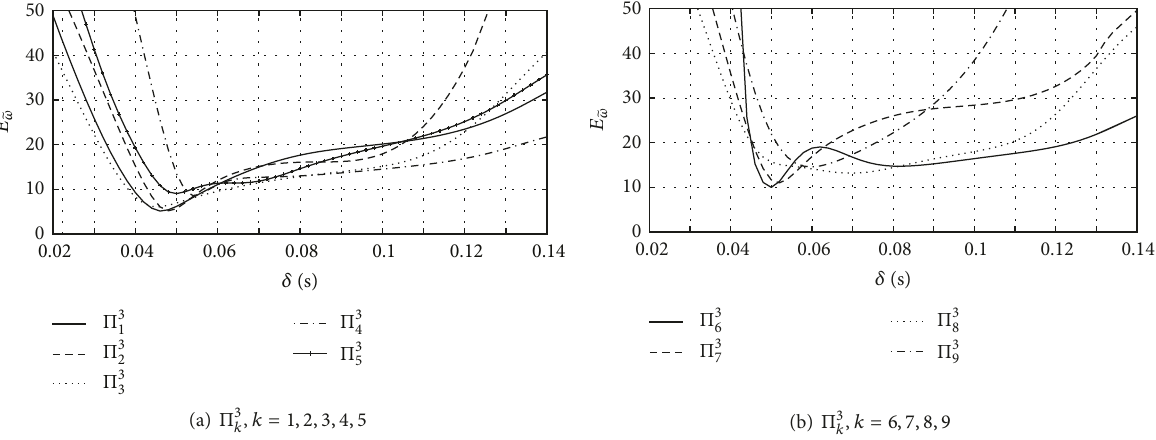
Figure 6: Function 𝐸 ̃𝜔 (𝛿) calculated with three instrumented floors.